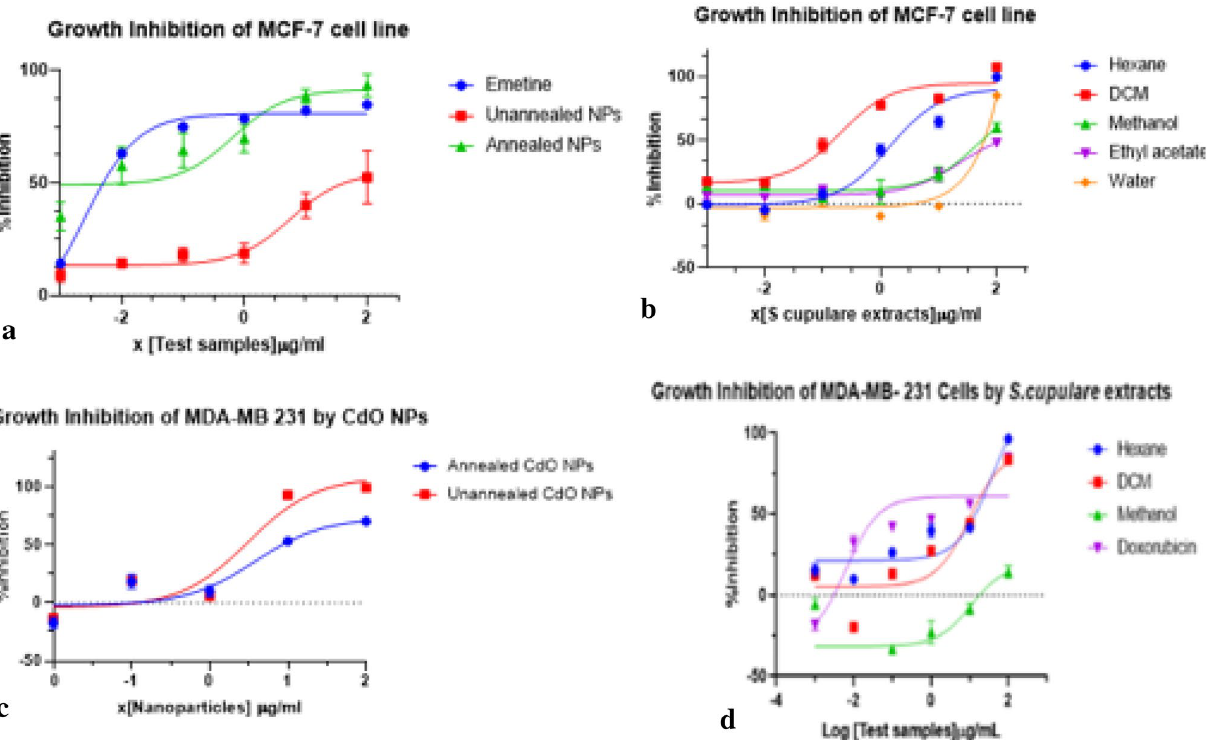
Figure 8. Growth inhibition of MCF-7 cell line by CdO/CdCO 3 nanoparticles test samples ( a ) and S. cupulare extracts ( b ). Growth inhibition of MDA-MB-231 cells by S. cupulare -derived CdO/CdCO 3 nanoparticles ( c ), and S.cupulare extracts ( d